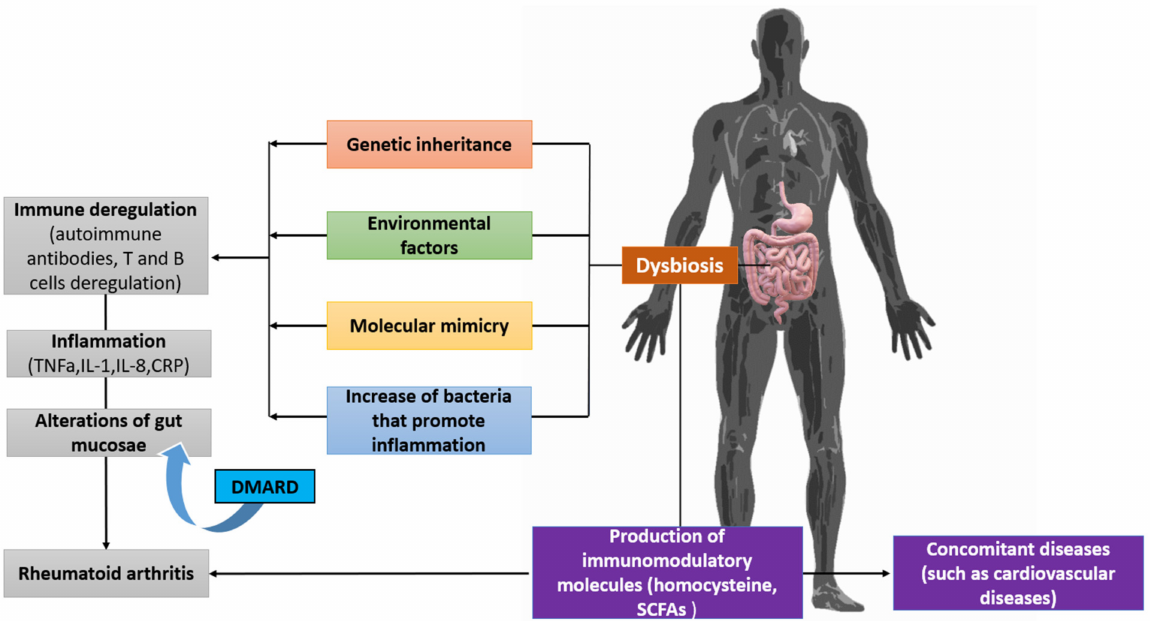
Figure 4. Dysbiosis and its association with the pathophysiology of rheumatoid arthritis. The molecular mimicry phenomenon, as well as the increase in the number of bacteria associated with inflammation, lead to de-regulation of the immune system [127]. Credit: Original figure by I.A.